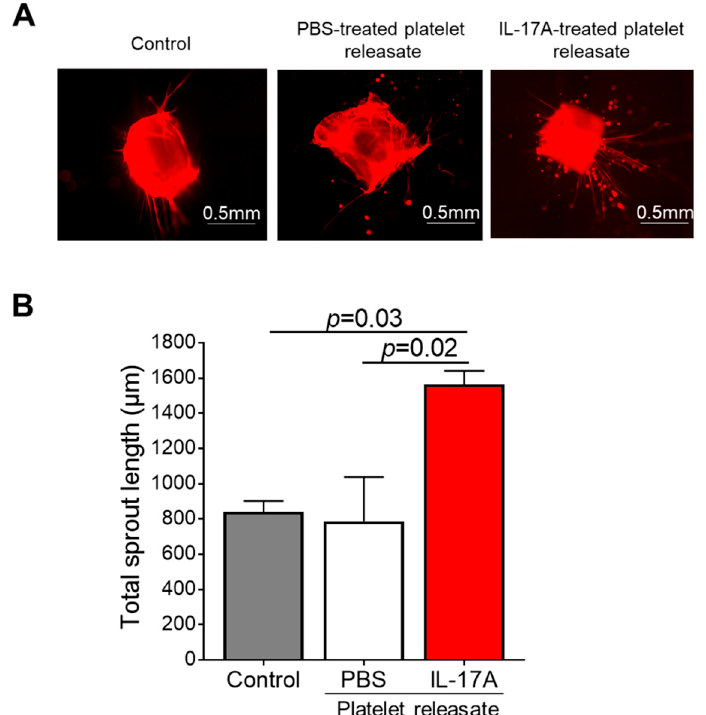
Figure 5. Murine IL-17A platelet releasate triggers aortic ring microvessel sprouting. ( A ) Aortic rings of approximately 1mm long embedded into collagen gel were incubated with medium (untreated rings; Control) or releasate from platelets prior stimulated with IL-17A (50 ng/mL) for 7 days. One representative picture of each group is shown. ( B ) Quantitative analysis of the mean total sprout length of three rings per experimental group and per experiment was performed. Data are shown as mean of the total sprout length ( μ m) ± SEM of three independent experiments. With regard to statistics, adjusted p -value as determined by one-way ANOVA and Dunnett’s multiple comparison test is reported per indicated comparison. Scale bars indicate 0.5 mm.